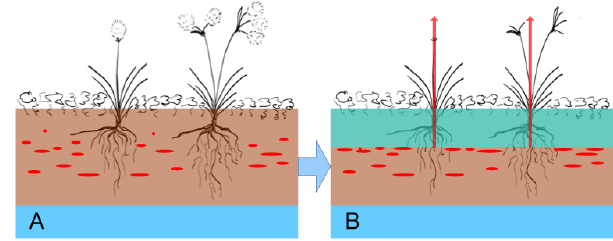
Fig. 6. Hyphotetical scheme of mechanism for late-season CH 4 and CO 2 emissions. A summer; B autumn. See the description in the text.